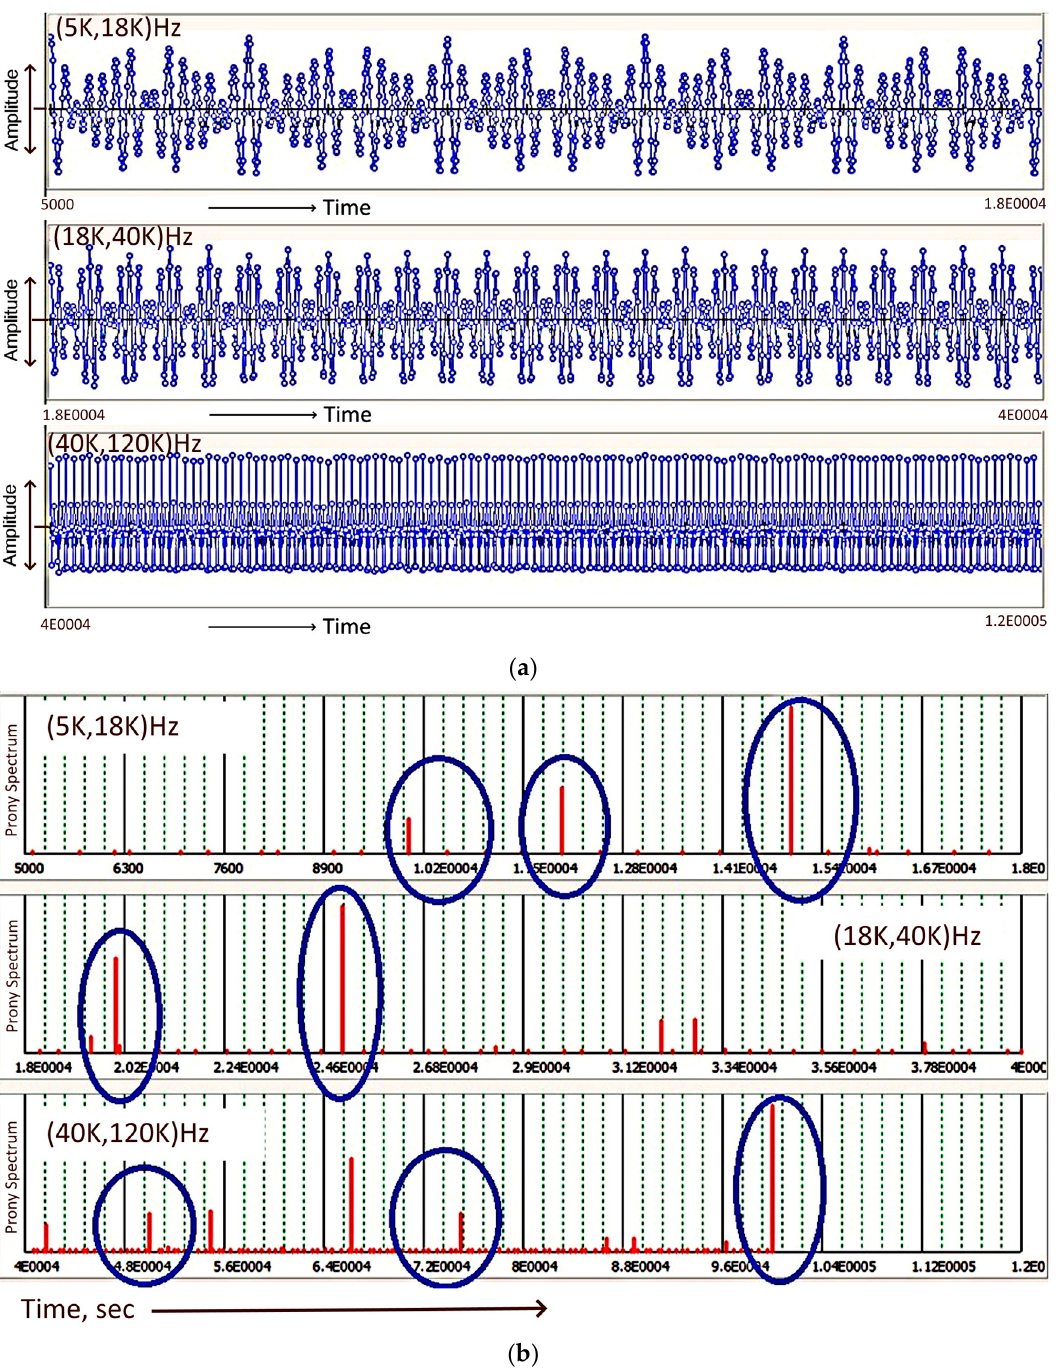
Figure 8. Decomposition of the signal by the frequency subbands of the sensors. ( a ) time signal, ( b ) its A 2 —the Prony spectrum. Model signal modes are circled with blue ovals [79,80].